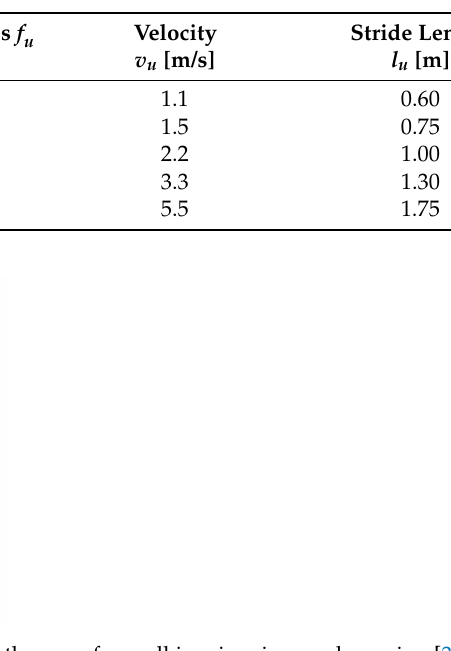
Table 2. The frequency, velocity, and stride length range for walking, jogging, and running [35,36].